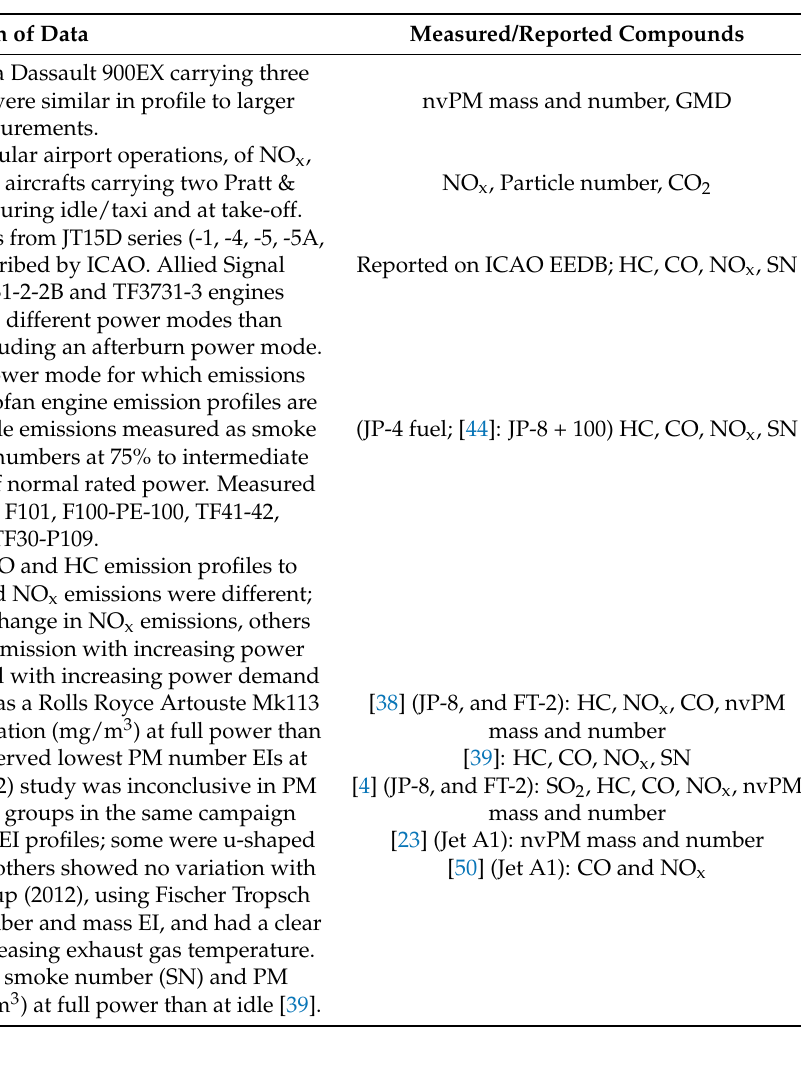
Table 1. Summary of Data on Emission Profiles of non-Regulated